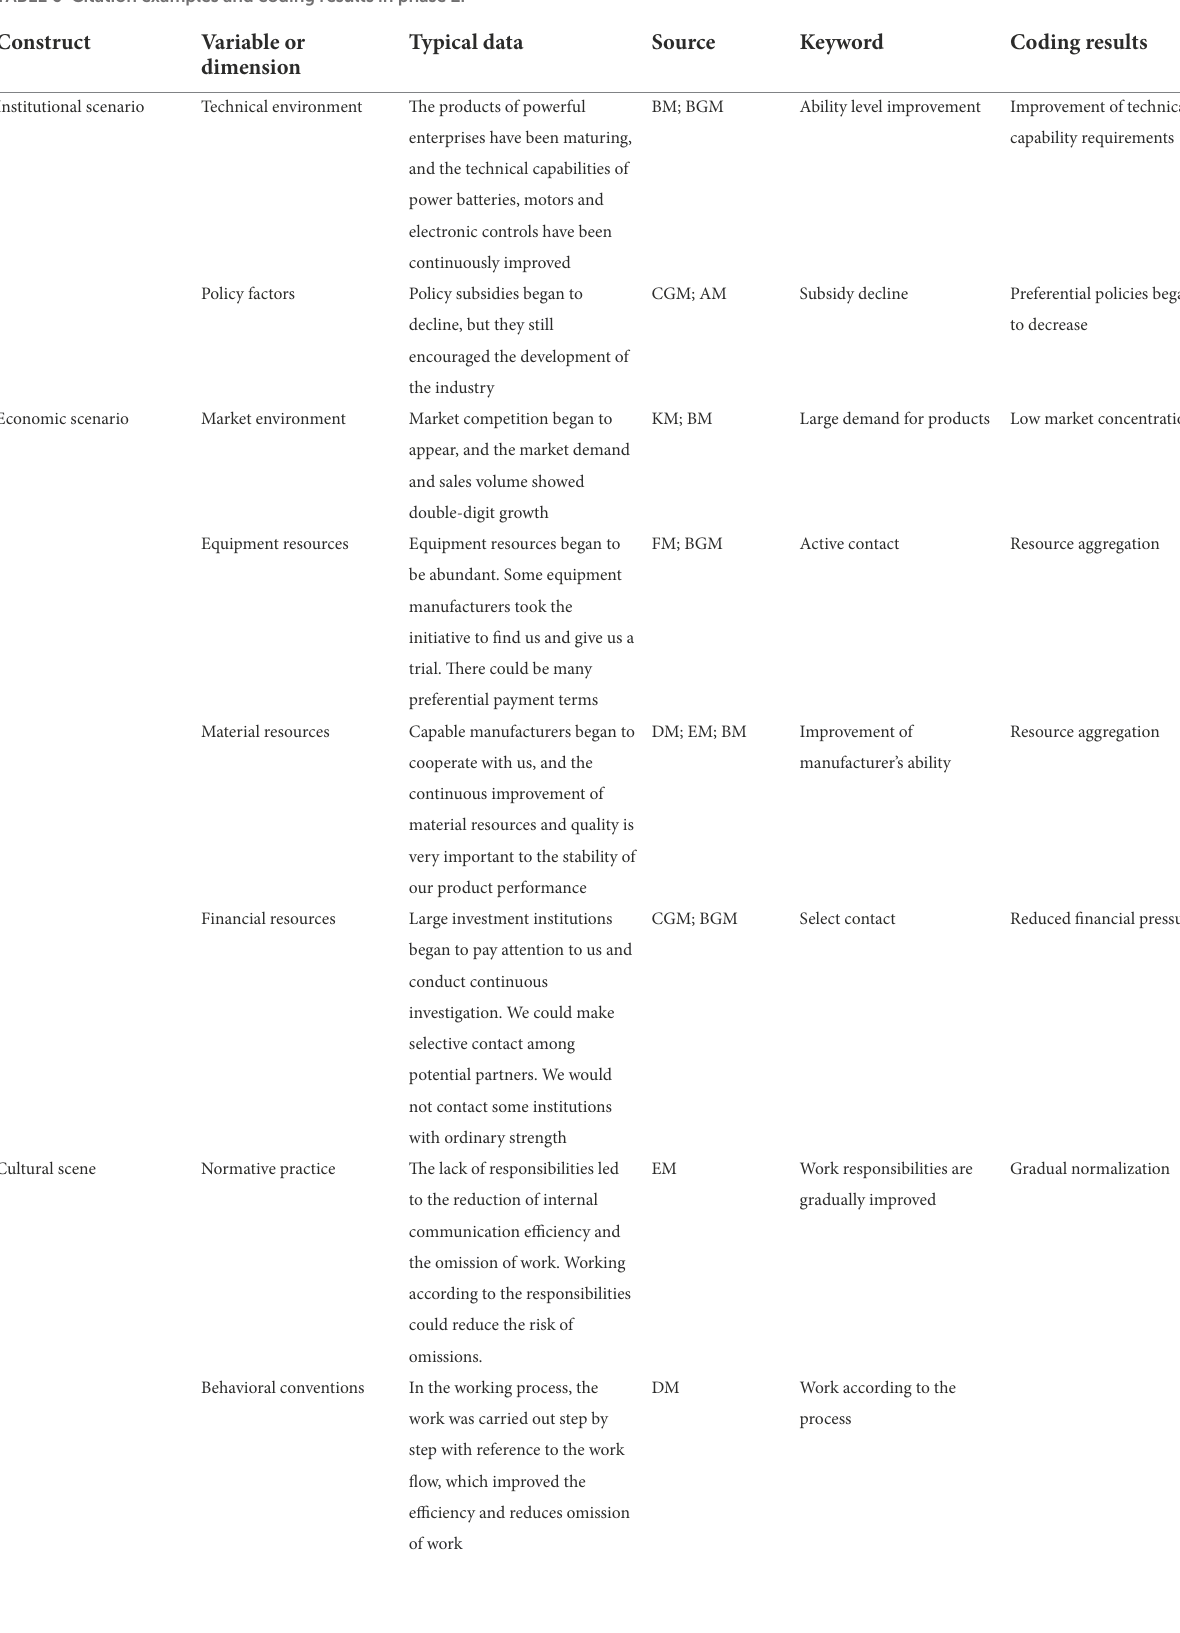
TABLE 6 Citation examples and coding results in phase